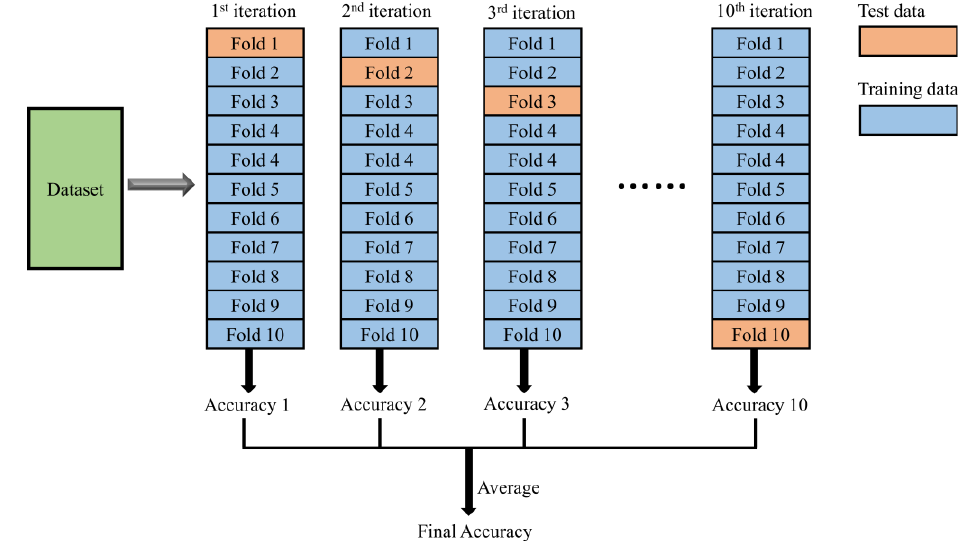
Figure 4 . Schematic diagram of 10-fold cross-validation. Figure 4. Schematic diagram of 10-fold Table 1. Accuracy percentage 10-fold cross-validation for each fold.